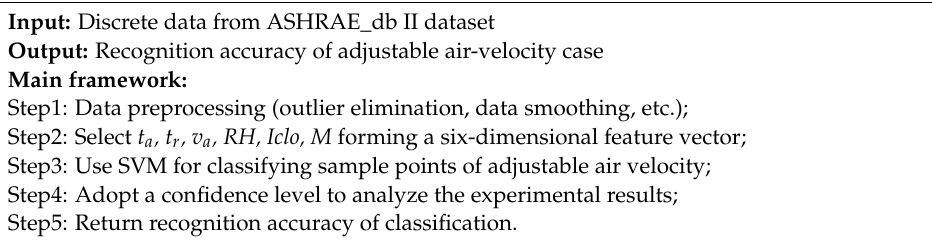
Algorithm 1: Classification algorithm for adjustable air velocity based on optimal comfort